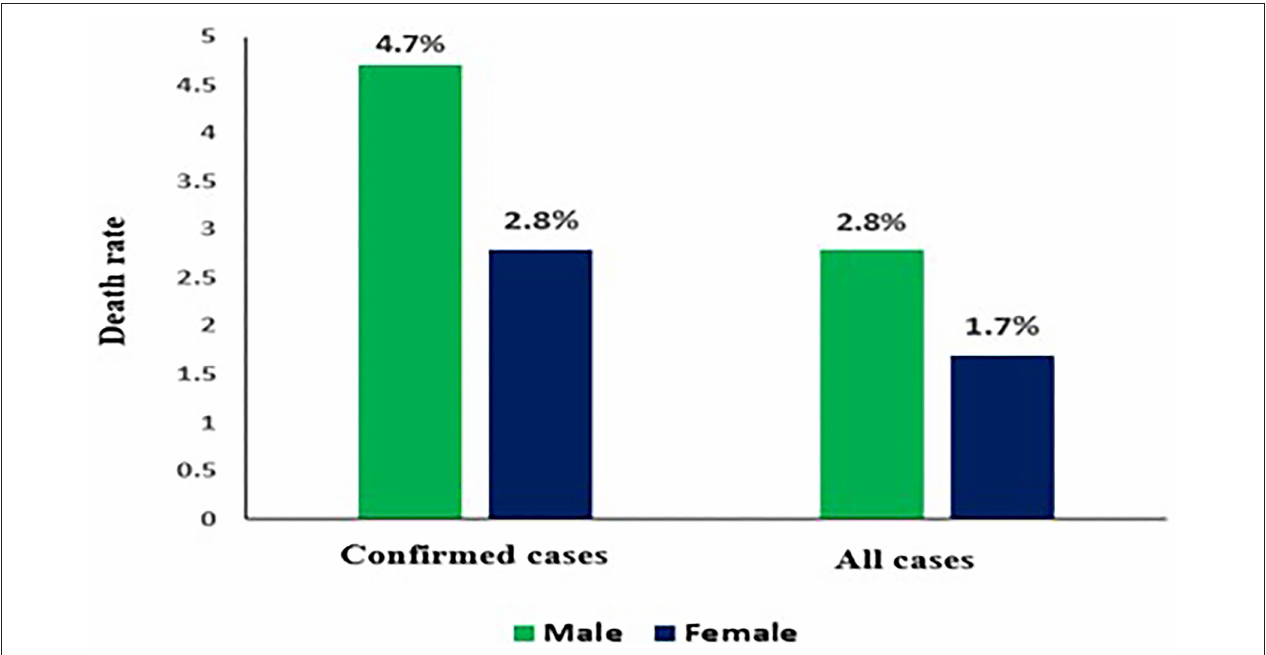
FIGURE 5 | COVID-19 death rate by sex